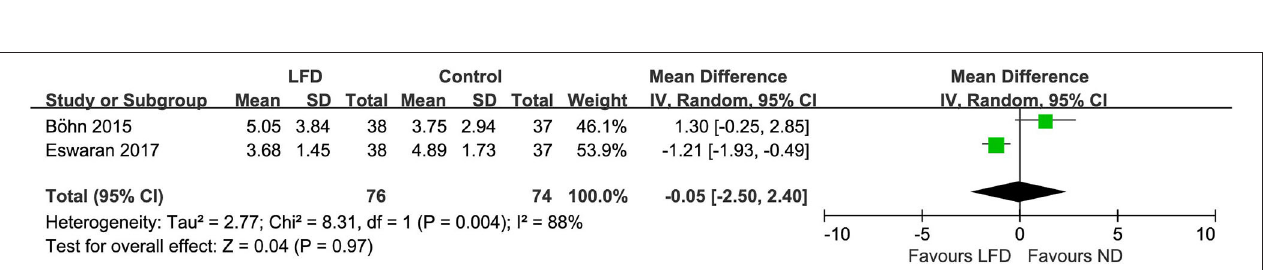
FIGURE 7 | Pooled mean difference for anxiety score based on the hospital anxiety and depression scale. LFD, low-FODMAP diet; ND, normal diet.